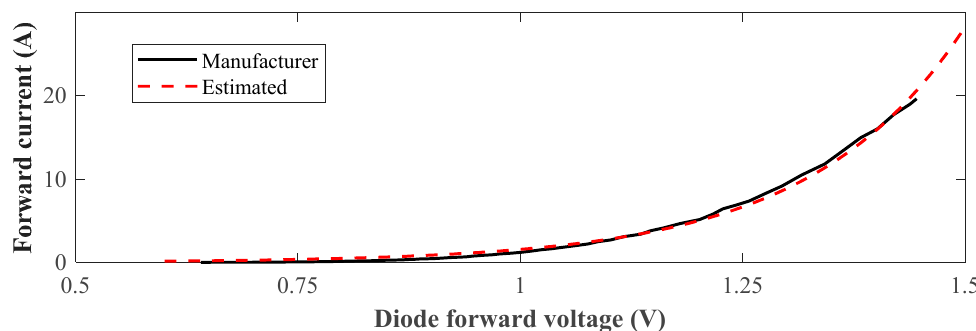
Figure 14. Manufacturer and estimated I–V curves of the rectifier diodes.